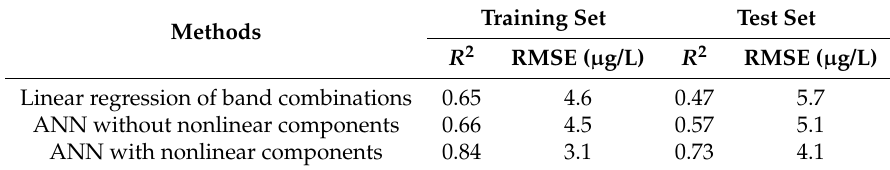
Table 2. Estimation results of linear regression and ANN-based methods in Lake Erie.